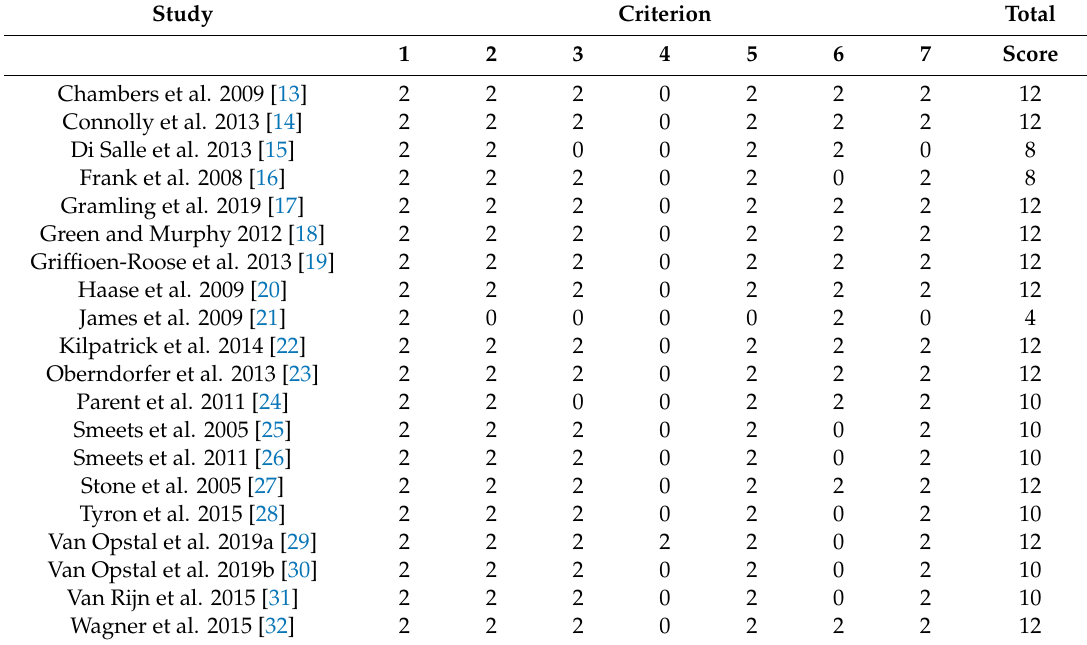
Table 2. Quality